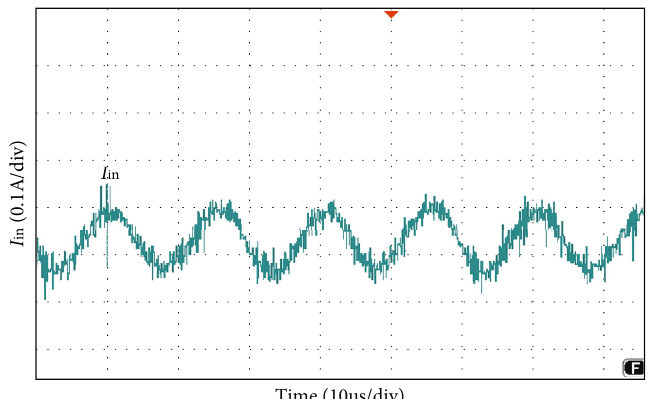
Figure 18: Input current